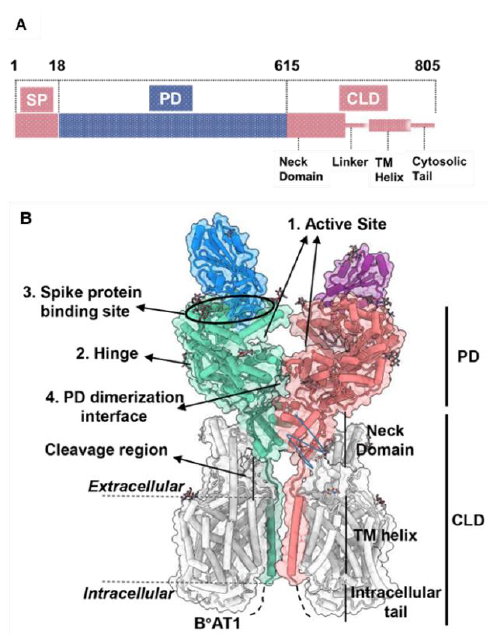
Figure 2. ACE2 gene domain organization and protein structure. ( A ), Full-length ACE2 containing a signal peptide (SP), an N-terminal peptidase domain (PD), and a C-terminal collectrin-like domain (CLD). ( B ), Protein structure of full-length ACE2 dimer in complex with B°AT1 (PDB ID: PDB 6M17). B°AT1 is presented in grey and four key sites (1 – 4) are highlighted. The numbers (1 – 805) indicate the amino acid residues. Adapted from Ref. [31] with permission from the publisher. © 2020 Wiley-VCH GmbH.